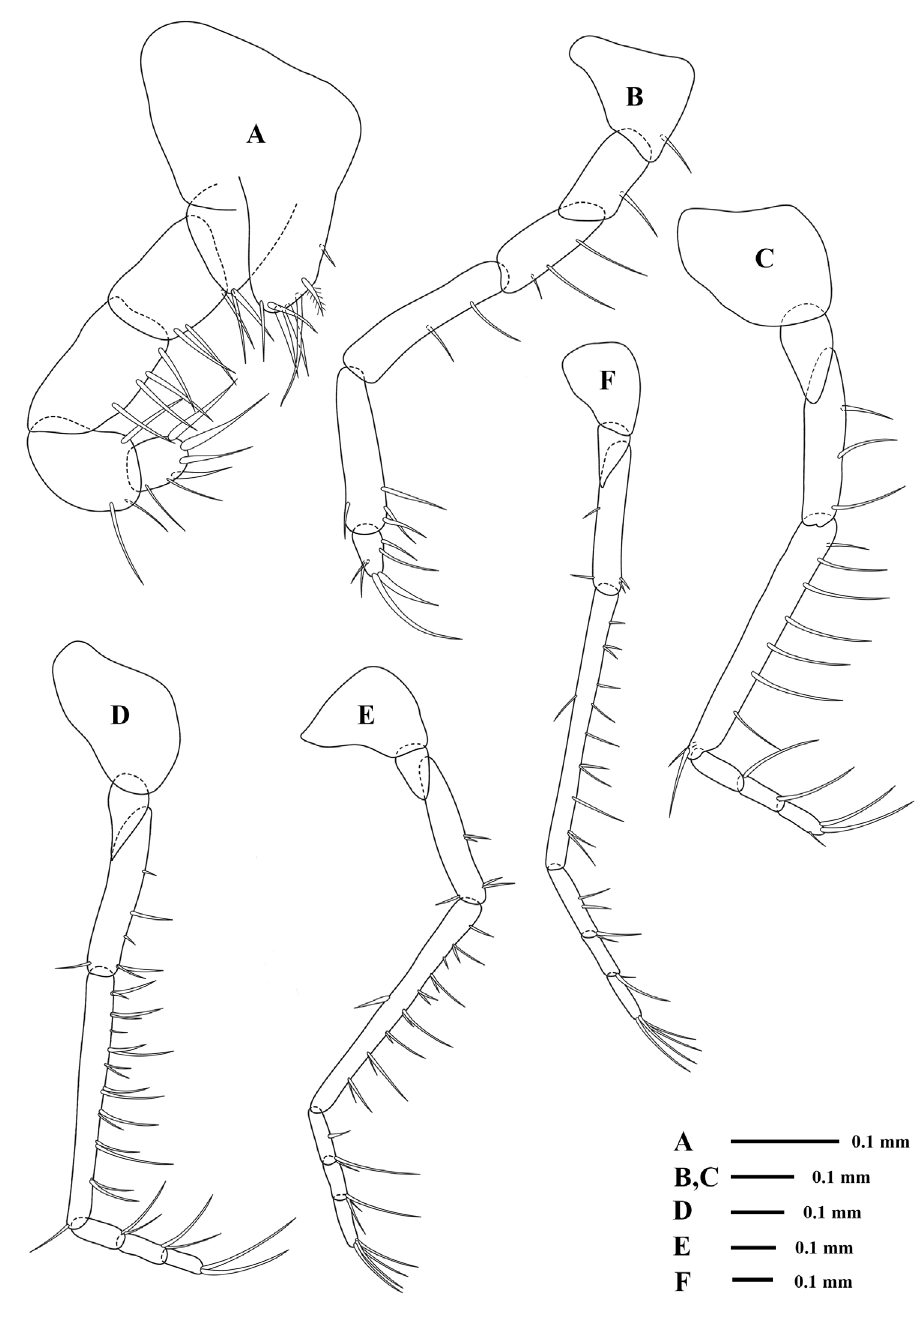
Figure 4. Rhopalophthalmus longipes ; A endopod of first pereopod B endopod of second pereopod C en- dopod of third pereopod D endopod of fourth pereopod E endopod of fifth pereopod F endopod of sixth